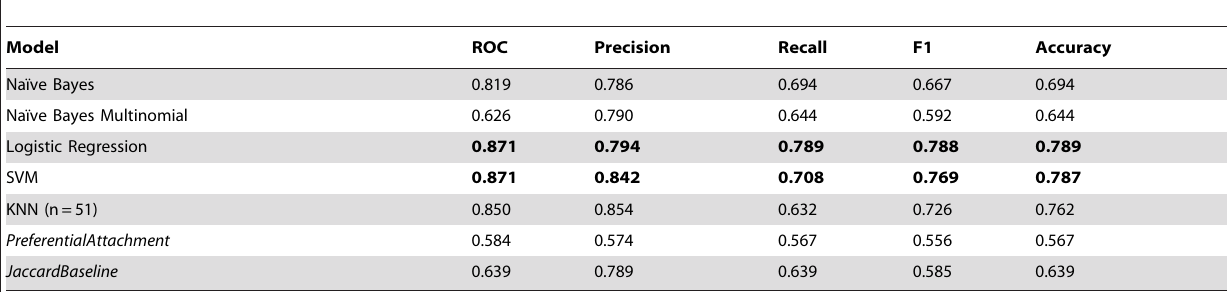
Table 4. RandomPairCategory evaluation results.